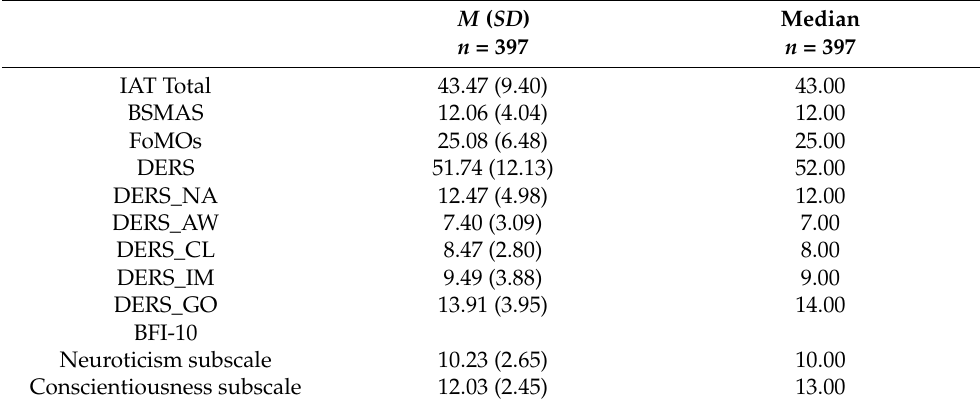
Table 1. Descriptive statistics for the IAT, BSMAS, FoMOs, DERS, and BFI-10 Neuroticism and Conscientiousness